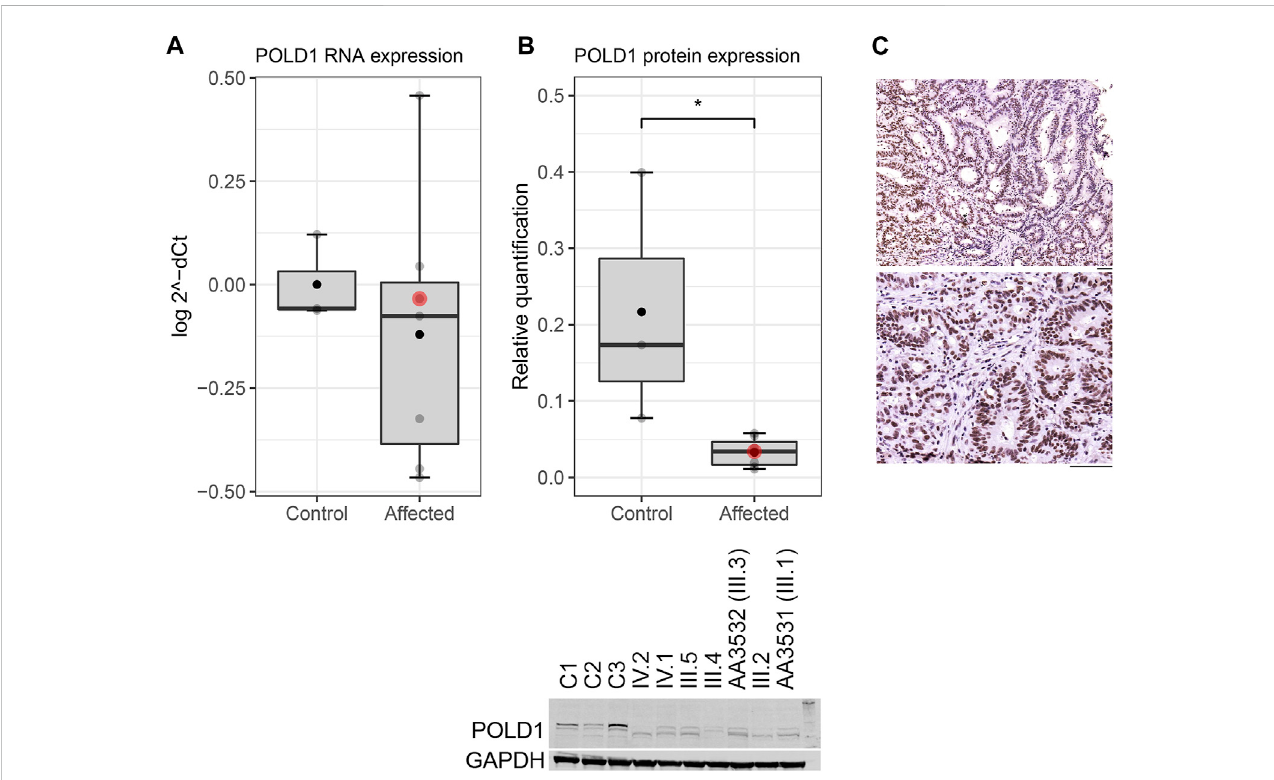
FIGURE 3 POLD1 expression in POLD1 p.Lys648fs*46 variant carriers at both (A) RNA and (B) protein levels. A signi fi cant difference of POLD1 protein expression wasdetectedin POLD1 p.Lys648fs*46 carriers(affected) versus healthycontrols(Wilcoxontest, p < 0.05).The horizontallinemarksthemedianvalue,andthe black dot indicates the mean value. The proband is indicated by a red dot. (C) Nuclear detection of POLD1 in two different adenocarcinoma sections from a proband ’ s tumor sample. Scale bars, 50